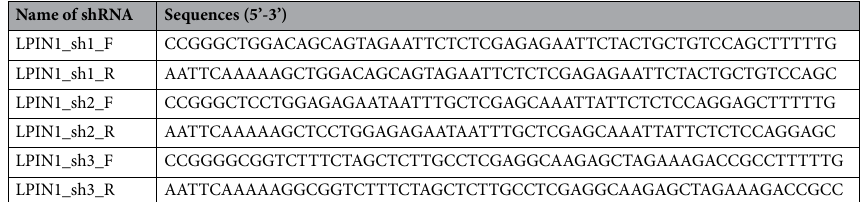
Table 1. Information of shRNAs used for the knockdown of LPIN1 .